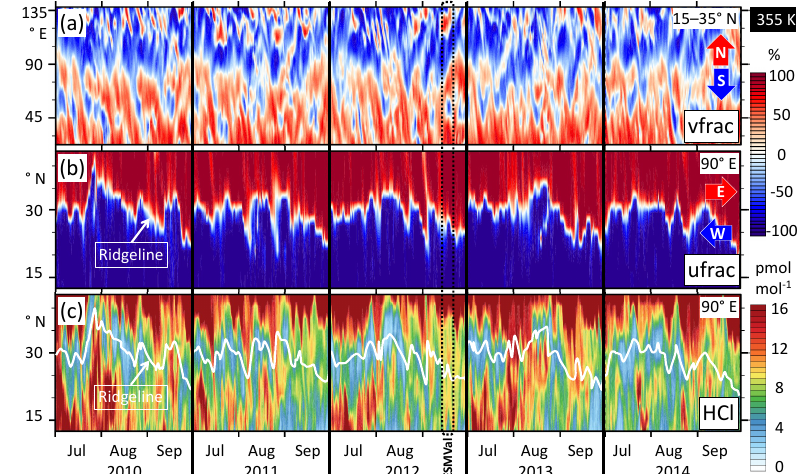
Figure 3. Exploratory analyses of the frequency of occurrence of (i) dynamical instabilities of the ASMA and (ii) transport of TL air in the free troposphere along the southern ASMA fringe. All panels show 10-hourly EMAC simulation results at the 355K isentropic level, for p u 2 + v 2 , with meridional velocity v and the summer monsoon months in the ASMA region. (a) Meridional wind fraction (calculated as v/ zonal velocity u ) along a wide zonal transect, averaged with dry grid-cell mass weighting at each longitude from 15 to 35 ◦ N. Blue shades indicate southward and red shades northward winds. Each red–blue pair (from west to east) at a given time marks an anticyclone or a smaller p u 2 + v 2 ) along a meridional transect at 90 ◦ E. Blue shades indicate westward and eddy. (b) As in panel (a) , but for zonal wind fraction ( u/ red indicates eastward winds. (c) Time evolution of HCl mixing ratios. At any given time, locally increased HCl south of the ridgeline is a proxy for air from the TL or the stratosphere.